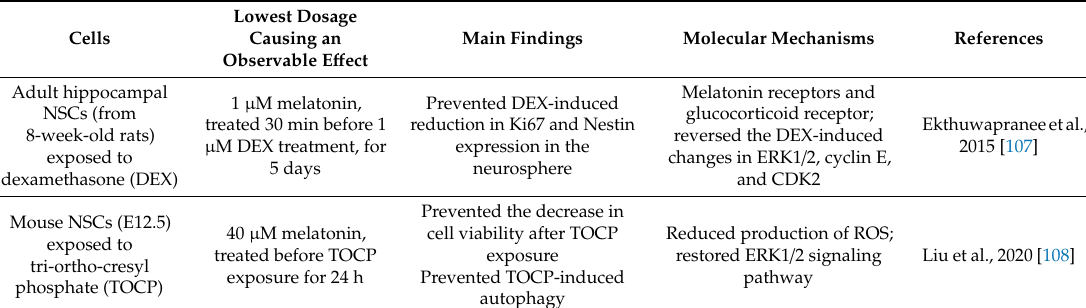
Table 11. Table showing the main findings regarding the e ff ects of melatonin on neurogenesis impairment caused by environmental factors and the respective molecular mechanisms in the in vitro